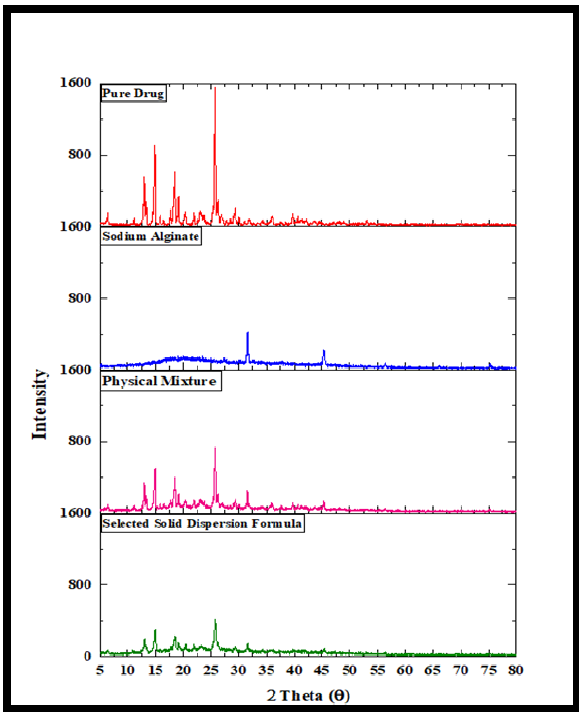
Figure 4. XRD diffractograms of MLX, SA, PM and SD1 Fourier transform infrared